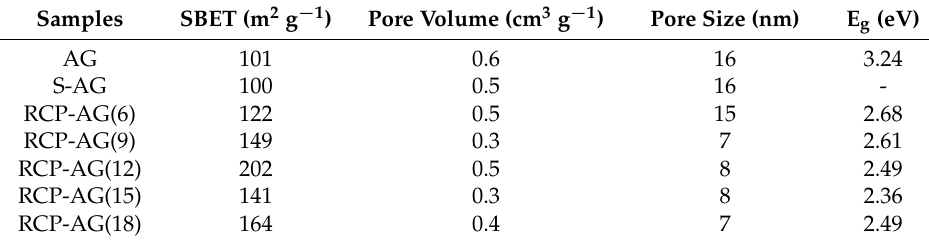
Figure 2. N 2 adsorption/desorption isotherm of samples. Table 1. Summary of textural properties and band gaps of the